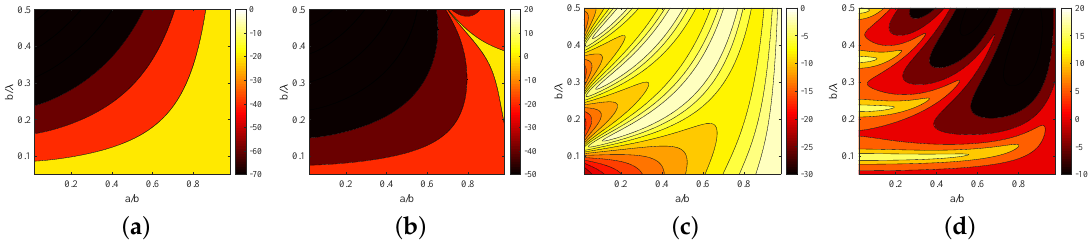
Figure 8. ( a , c ) Radiation efficiency e R in dB and ( b , d ) relative radiation power P rad / P inc in dB as a function of the aspect ratio a / b and electrical size b / λ for: ( a , b ) TM waves of Ag cladding and ( c , d ) TE waves of GaP